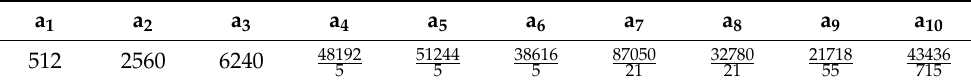
Table 1. List of constants for Equation